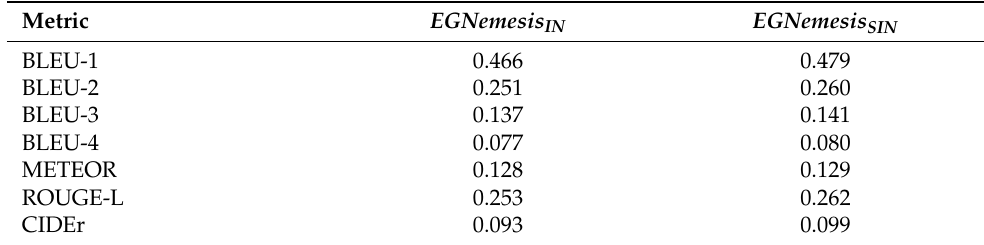
Table 5. Results with respect to the utilized image-to-emotion